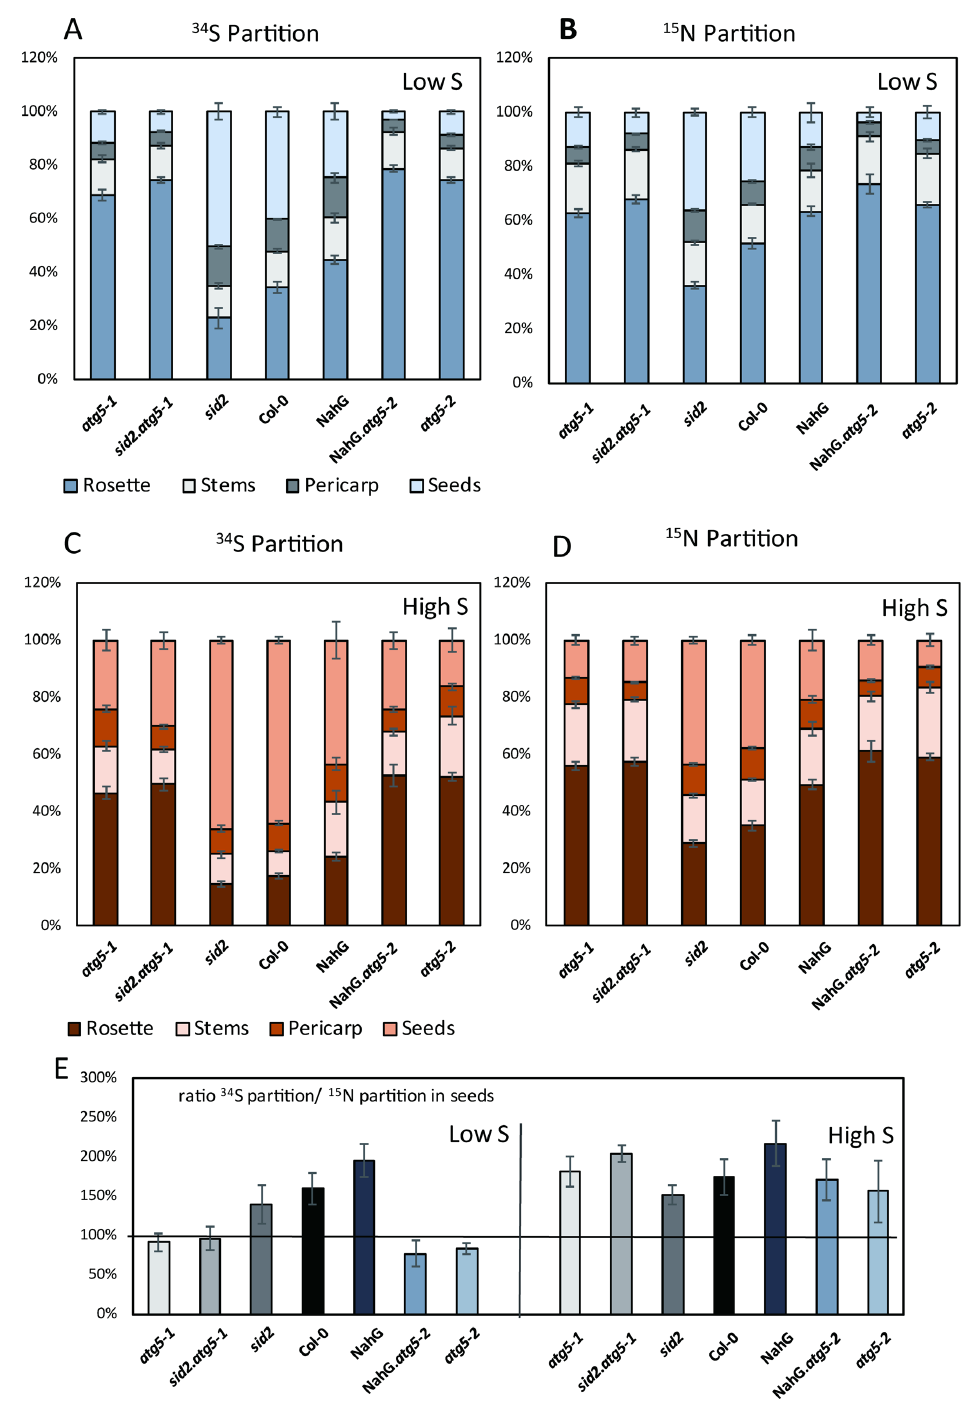
Figure 5. The remobilization of 34 S and 15 N to the seeds is di ff erentially modified by sulphate availability in atg5 autophagy mutants and control lines. The partitioning of 34 S ( A,C ) and 15 N ( B,D ) in the rosette, stem, pericarp and seeds of atg5 mutants and control lines under low S ( A,B ) and high S ( C,D ) conditions. The ratios of 34 S and 15 N partitions in the seeds show di ff erent patterns depending on genotypes under high S and low S conditions ( E ). Data are the adjusted means and SD from two biological repeats with six plants each. The di ff erent letters indicate values significantly di ff erent at p < 0.05 (n = 12), as determined using an ANOVA Newman–Keuls (SNK)